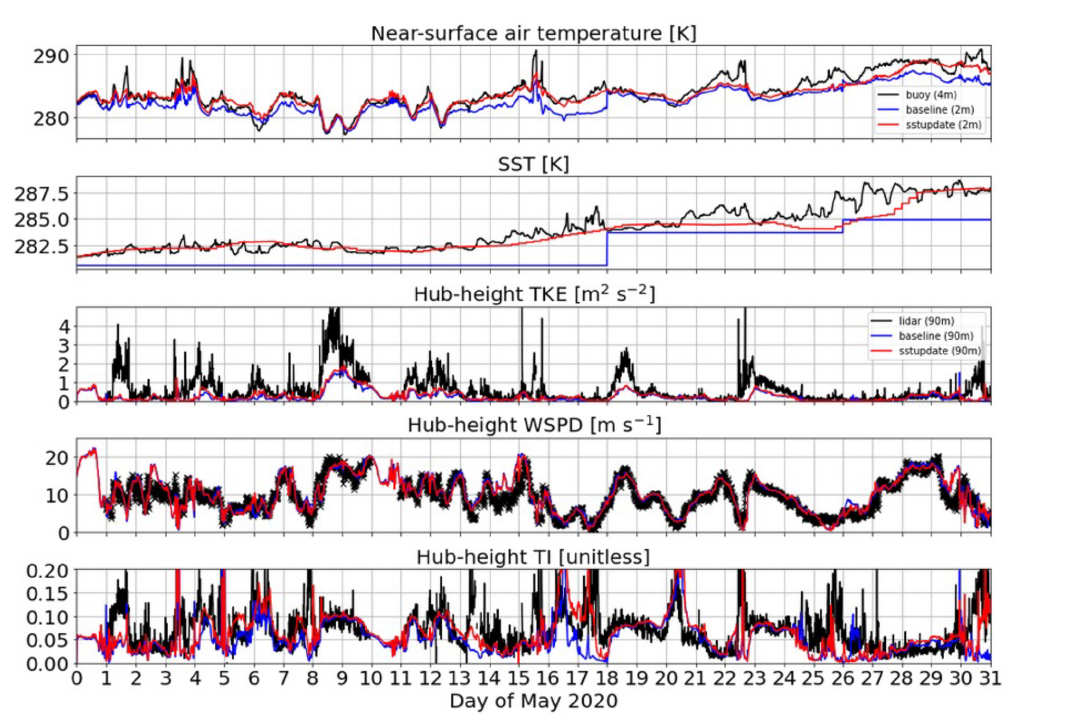
Figure 8. Time-series display of data from baseline, sstupdate simulations, and corresponding observations for May 2020. From top to bottom rows, the near-surface air temperature, sea surface temperature, hub-height TKE, WSPD, and TI are displayed.